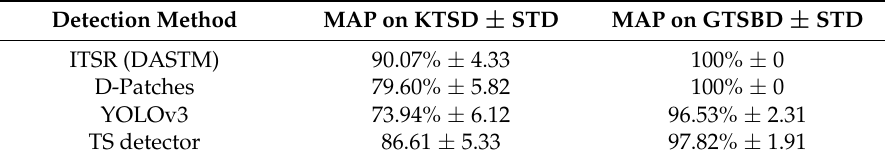
Table 2. Comparison of ITSR with D-Patches, YOLOv3 and TS detector.